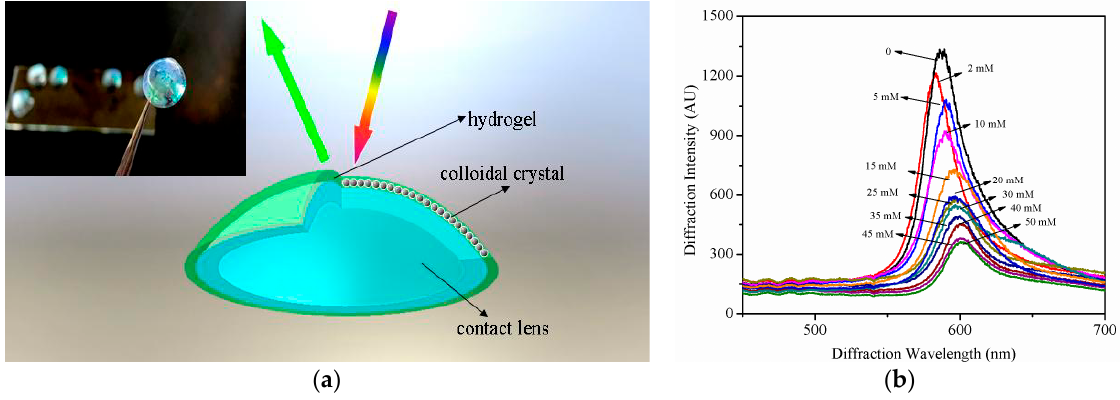
Figure 6. ( a ) Diagram and photograph (insert) of a physical hydrogel photonic crystal sensing lens; ( b ) Diffraction wavelength shifts with the variation of the glucose concentration in artificial tear solution.